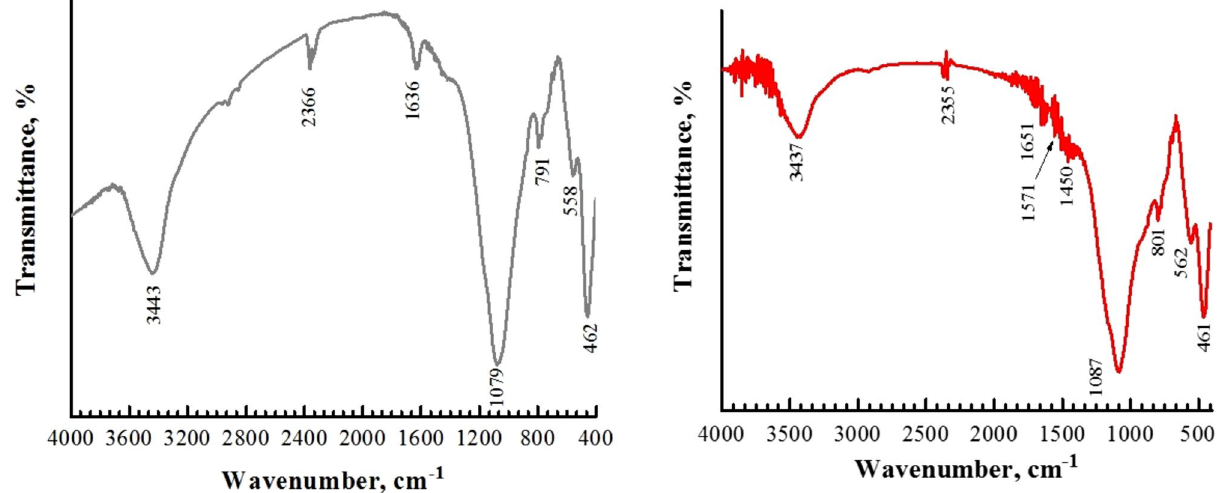
Figure 22. FTIR spectra: (left) before adsorption; (right) after adsorption.